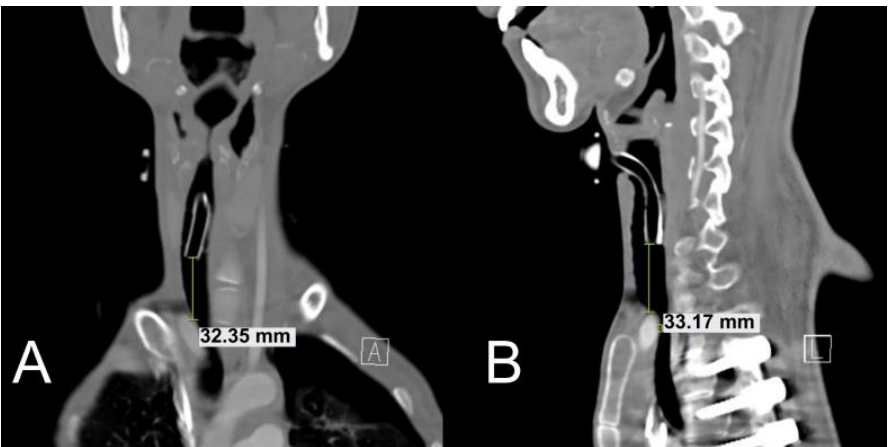
Figure 2. Neck computed tomography images after the high-level (cricothyroid level) tracheostomy approach. In ( A ) coronal and ( B ) sagittal views, the distance between the tracheostomy cannula tip and innominate artery was approximately 33 mm.